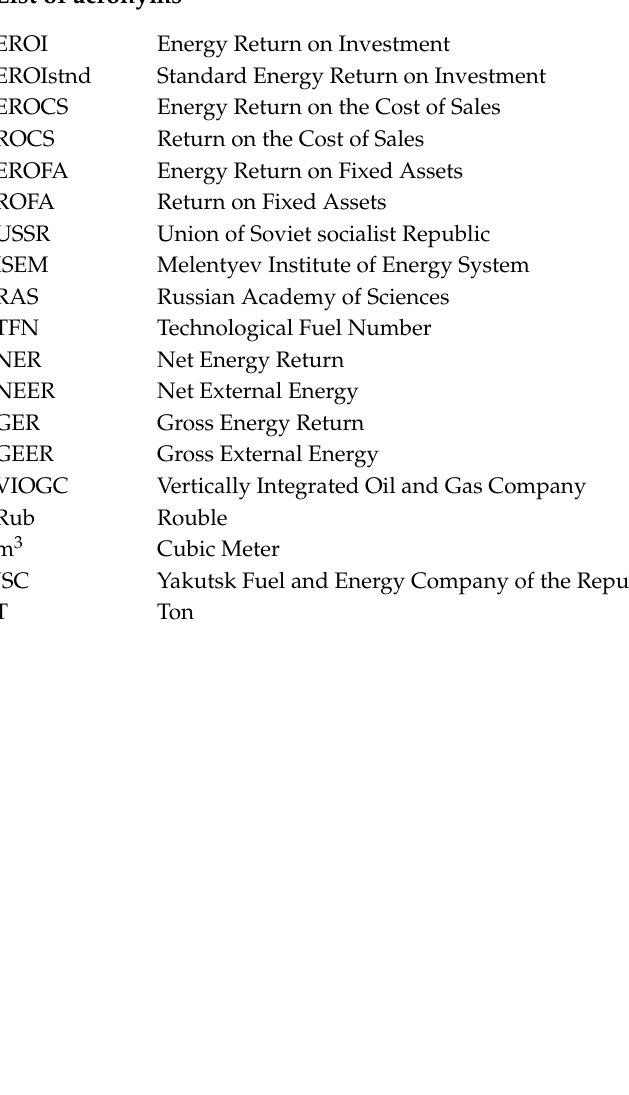
Table S3. ROFA data given for calculation. Table S4. Assets of JSC “YATEC” at the end of 2014 to calculate EROFA. Table S5. Volumes of realization of gas and expenses on acquisitions and delivery of methanol. Table S6. Material costs, energy consumption, and total capital costs of exploration. And production of JSC Yakutsk fuel and energy